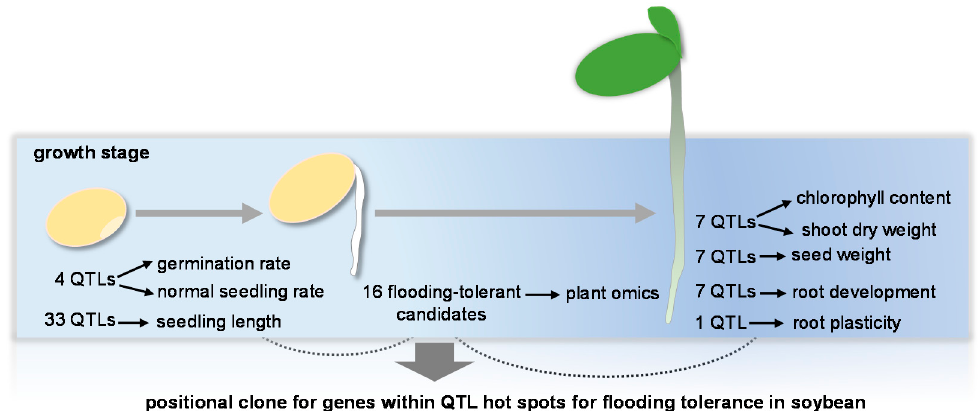
Figure 3. Interaction from QTL analysis and plant omics for flooding tolerance in soybean. QTLs associated with flooding tolerance in seed and at early vegetative growth stages are presented. Flood-tolerant indicators employed in phenotypic evaluation for QTL analysis are indicated. Flood-tolerant candidates were collected from transcriptomic and proteomic studies of soybean, including alcohol dehydrogenase 2, ATPase family AAA domain-containing protein 1, calnexin, calreticulin, chaperone 20, cytochrome P450 77A1-like, enolase, expansin-like proteins, eukaryotic aspartyl protease, glucose- 6-phosphate isomerase 1, glyceraldehyde 3-phosphate dehydrogenase, glycine-rich RNA-binding protein 3, hexokinase, matrix metalloproteinase, nascent polypeptide-associated complex, and phosphofructokinase. Blue background indicates flooding stress.